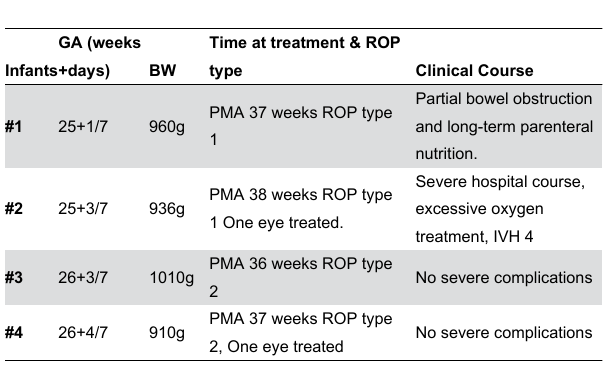
Table 3. Characteristics of Infants Treated for ROP but not Signalling a WINROP Alarm.